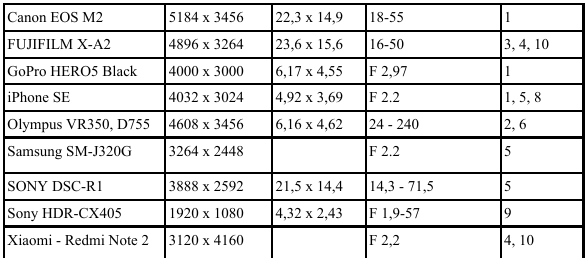
Table 2. Deployed cameras; surveyed tempels: 1 - Banyunibo ; 2 - Barong ; 3 - Gampingan ; 4 - Gebang ; 5 - Ijo ; 6 - Kalasan ; 7 - Kedulan ; 8 - Kimpulan ; 9 - Sambisari ; 10 - Situs